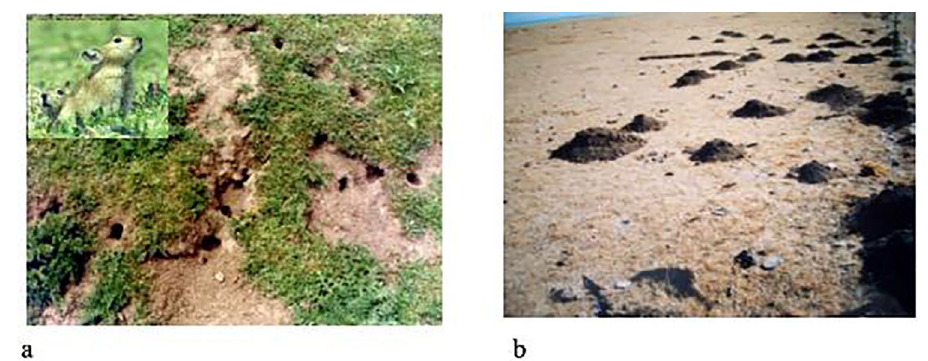
Figure 4. ( a ) Grassland damage caused by plateau pika, ( b ) Mound caused by plateau